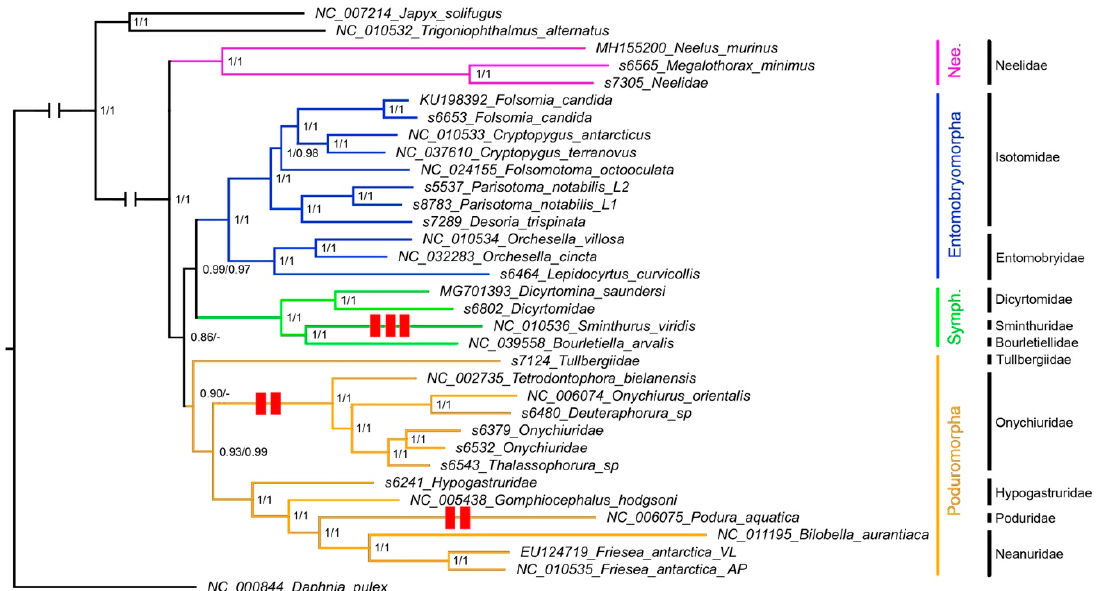
Figure 1. Phylogenetic reconstruction based on first / second codon positions. Numbers at nodes indicate support (posterior probability) for the node based on the first / second positions data set and the complete data set. - node not present in the second tree. Red rectangles indicate gene order variations. See Table 1 for complete information.